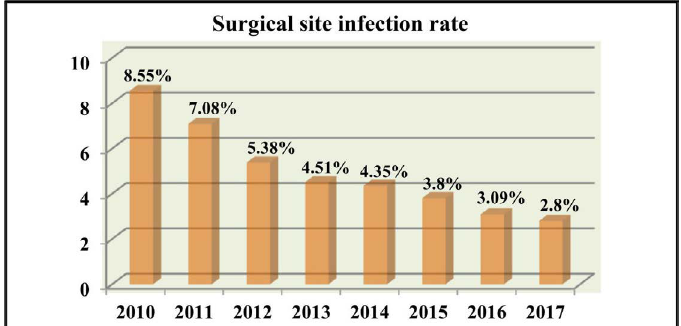
Fig. 5. Observed surgical site infection rate in the hospitals